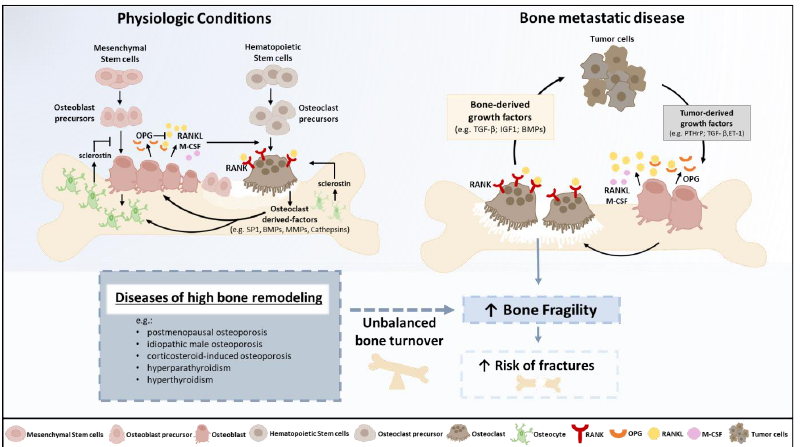
Figure 1. Bone remodeling in physiologic conditions and in metastatic disease. In physiologic conditions, bone resorption and bone formation are perfectly coordinated by bone cells (osteoclasts, osteoblasts and osteocytes), regulated by hormones, like parathyroid hormone (PTH) and 1,25-dihydroxyvitamin-D3, paracrine growth factors, and cytokines [26,33], to guarantee skeletal homeostasis. Bone-resorbing osteoclasts originate from hematopoietic stem cells, and bone-forming osteoblasts differentiate from mesenchymal precursors. The main bone remodeling regulator is the receptor activator of the nuclear factor- κ B (RANK)/RANK ligand (RANKL)/osteoprotegerin (OPG) axis. Osteoblasts release osteoclastogenic factors, such as the macrophage-colony-stimulating factor (M-CSF) and RANKL. Osteocytes also contribute to the bone remodeling balance by inhibiting os- teoblast or promoting osteoclast differentiation. In metastatic disease, bone homeostasis is disrupted, and bone remodeling is unbalanced towards osteolysis. Tumor cells secrete growth factors that stim- ulate osteoclast differentiation and activity, like parathyroid hormone-related peptide (PTHrP) and interleukin-11 (IL-11). The bone destruction process releases bone-derived growth factors supporting tumor cell growth, like transforming growth factor β (TGF β ) and bone morphogenetic proteins (BMPs), creating a vicious cycle. This unbalanced bone turnover elicits or increases bone fragility, increasing fracture